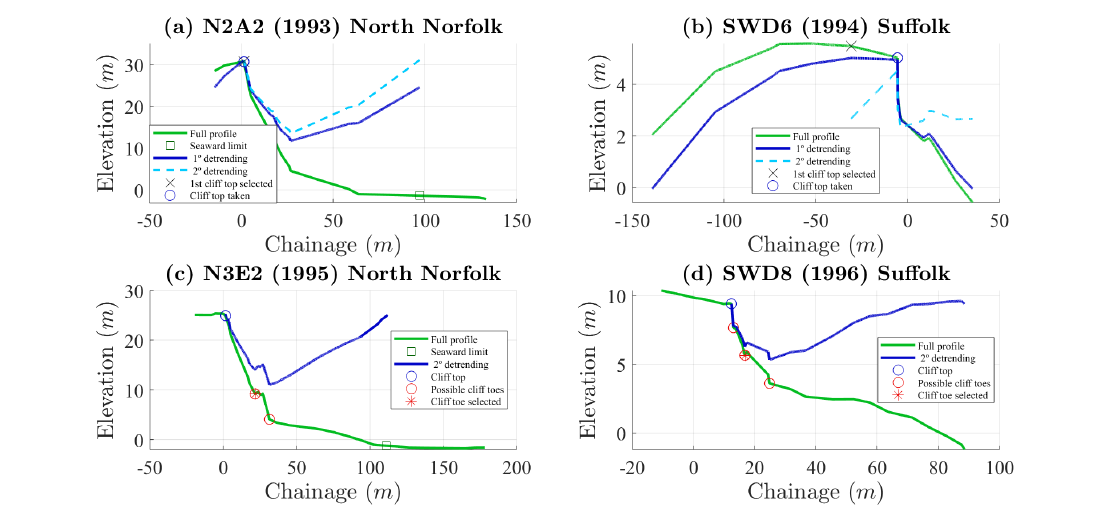
Figure 3. Examples of cliff top and toe extraction. ( a ) Cliff top extraction for North Norfolk (profile N2A2, 1993), where the iterative detrending and the seaward limit are shown. ( b ) Cliff top extraction for Suffolk (profile SWD6, 1994), where the iterative detrending is shown. ( c ) Cliff toe extraction for North Norfolk (profile N3E2, 1995), where the iterative cliff toe calculation and the seaward limit are shown. ( d ) Cliff toe extraction for Suffolk (profile SWD8, 1996), where the iterative cliff toe calculation is